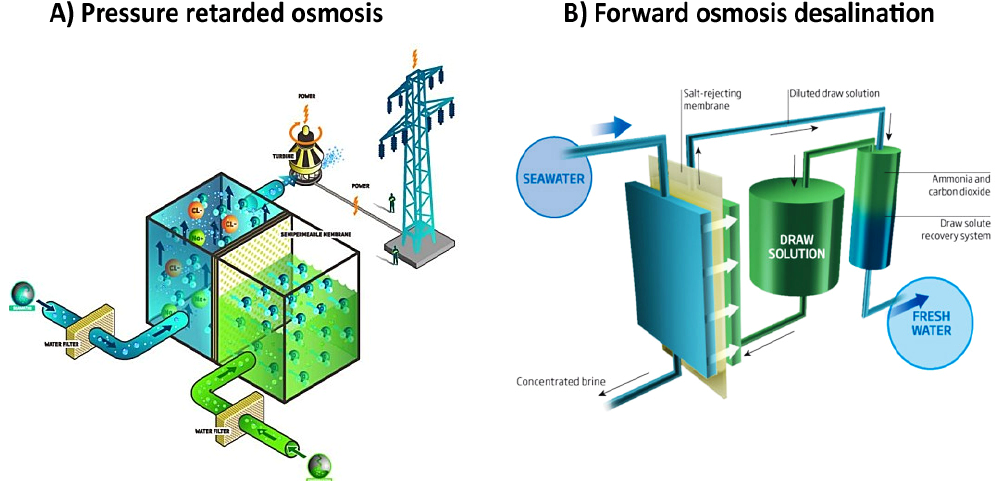
Figure 2. ( A ) An illustration of a PRO power plant [13]; ( B ) An illustration of forward osmosis desalination